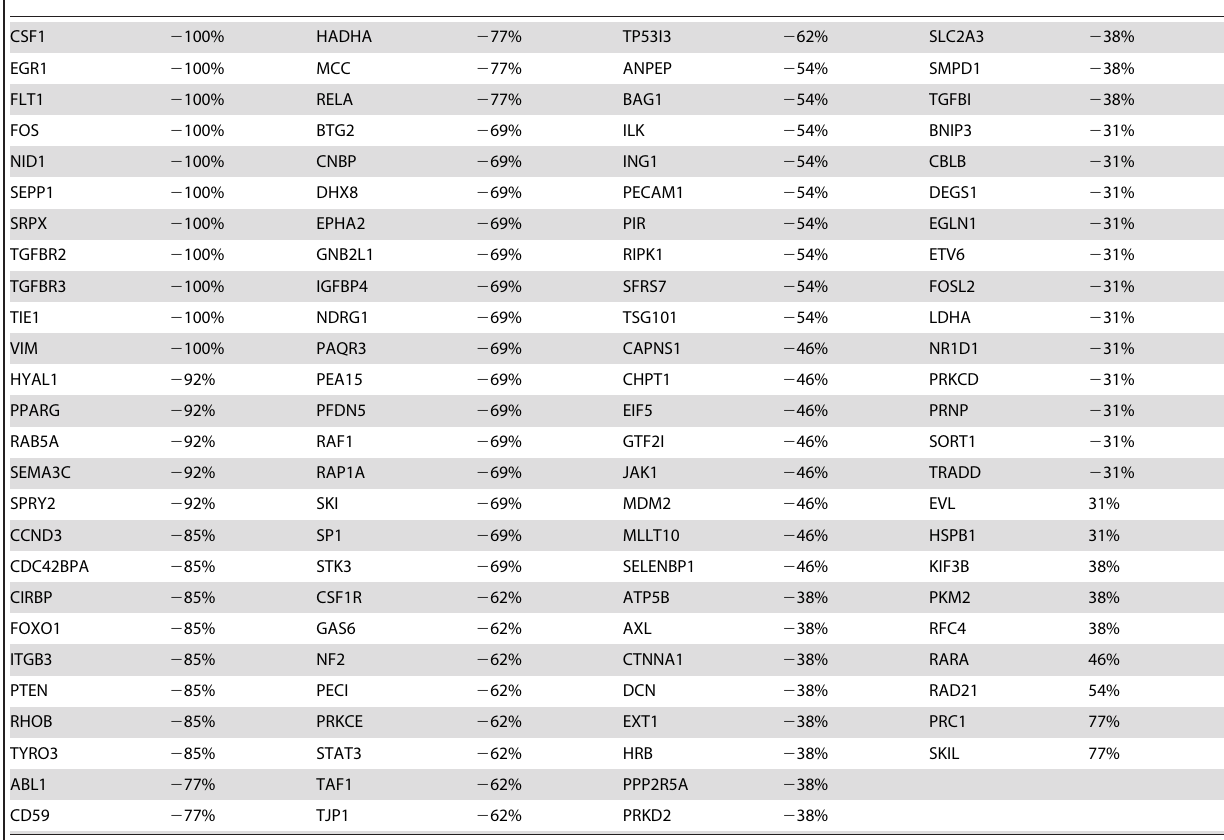
Table 3. Genes resulting from the OpenArray